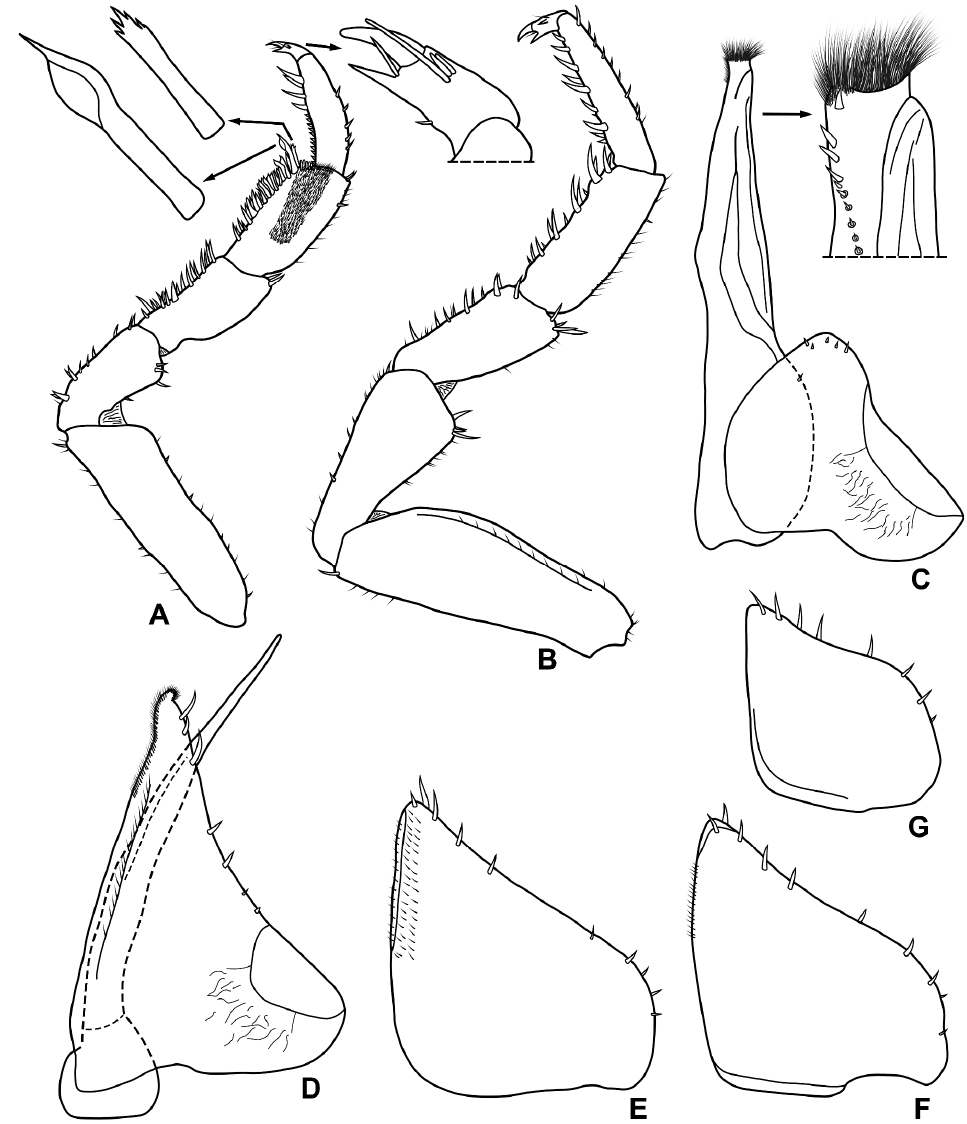
Figure 12. Porcellio incavatus sp. n., paratype ♂ from Santo Stefano d’Aveto. ( A ) Pereopod 1. ( B ) Pereopod 7. ( C ) Pleopod 1. ( D ) Pleopod 2. ( E ) Pleopod 3 exopod. ( F ) Pleopod 4 exopod. ( G ) Pleopod